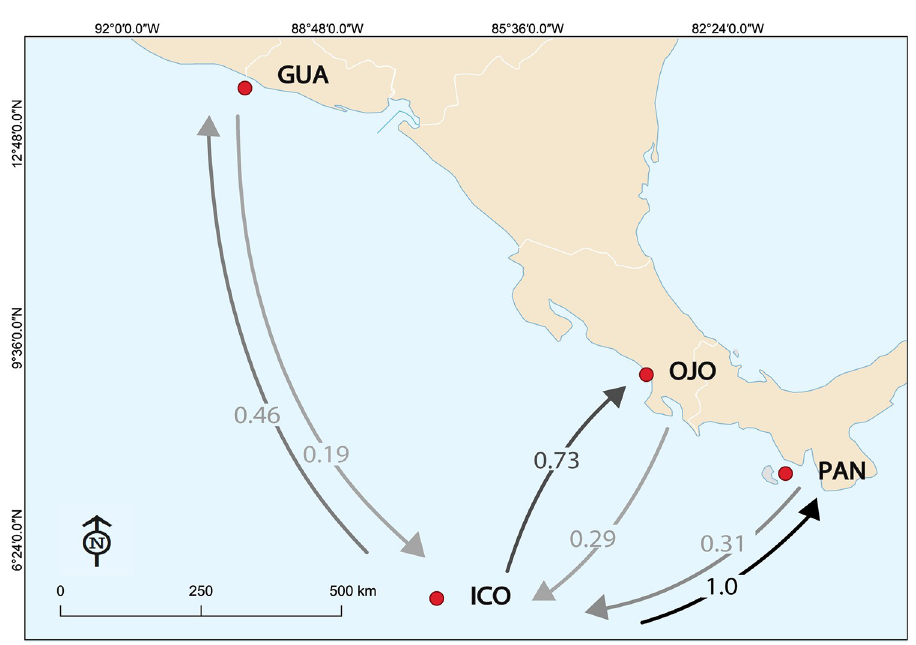
Fig 5. Contemporary gene flow estimated from 9 microsatellite loci genotypes with the divMigrate function. Arrows represent the relative number of migrants and estimated direction of gene flow between three coastal areas: Guatemala (GUA), Costa Rica (OJO), Panama (PAN); and an oceanic island: Cocos Island (ICO). The darker the arrow, the higher the relative number of migrants between sampling locations.